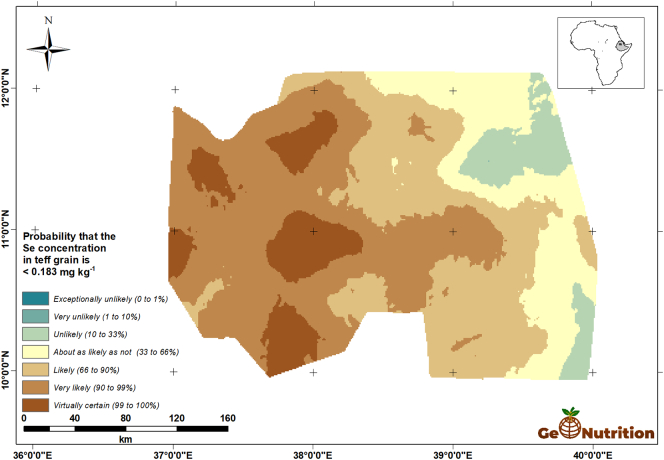
Probability that Se concentration in teff grain <0.183 mg kg−1 using a verbal scale of calibrated phrases from Mastrandrea et al. (2010).